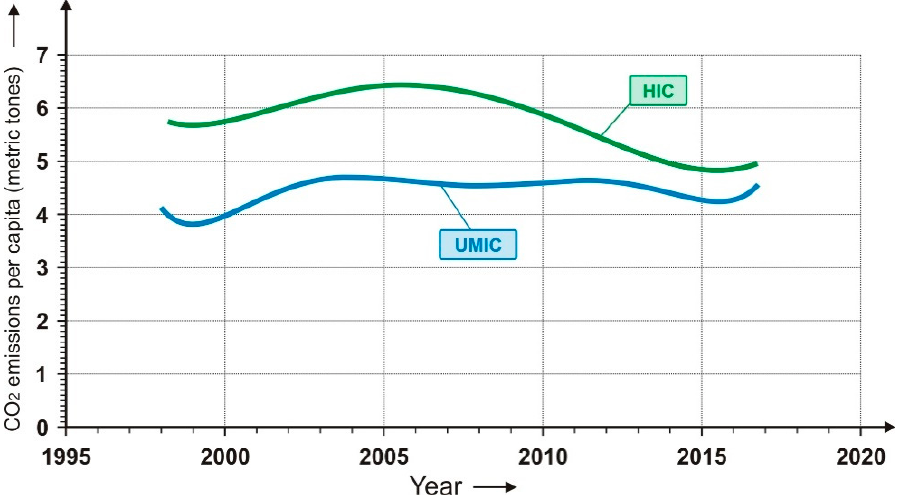
Figure 4. Average CO 2 emissions per capita in HIC and UMIC groups (1998–2019) (Authors’ crea- tion).